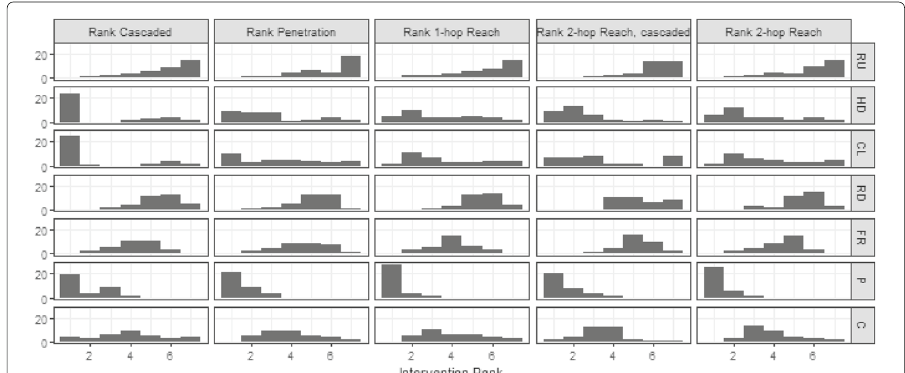
Fig. 2 Relative effectiveness of interventions over all simulations with complex contagion. Only simulations with threshold values of 0.4 or 0.5 are included. The average of each output variable is calculated over the set of simulations with the same intervention, network and threshold. The interventions are then ranked within the network and threshold combination, with equal effectiveness assigned equal rank. The chart summarises the 34 rankings (17 networks, 2 thresholds) with rank of 1 (best) at the